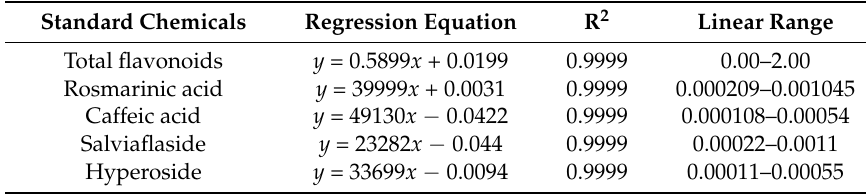
Table 3. Calibration curves of 5 standard chemicals.